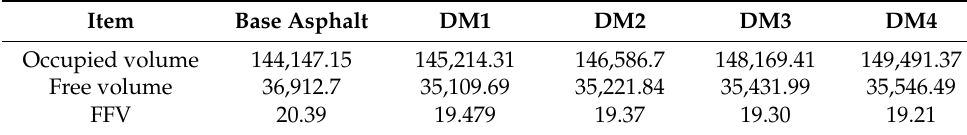
Table 5. The fractional free volume of asphalts (331 K).